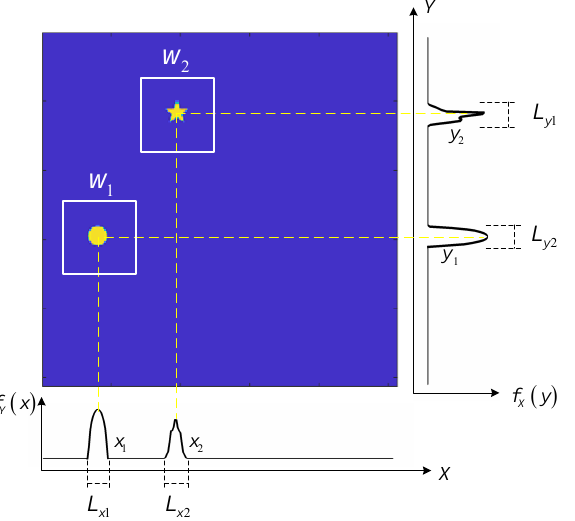
Figure 2. Illustration of multi-target locating via the projected curves method. f Y ( x ) and f X ( y ) are the projection of the scene image on the X axis and the Y axis. ( x 1 , x 2 ) and ( y 1 , y 2 ) are the regions where targets exist on the X axis and the Y axis. ( L x 1 , L x 2 , L y 1 , L y 2 ) are the length of the regions. ( w ) represents the window functions designed for the two 1 , w 2